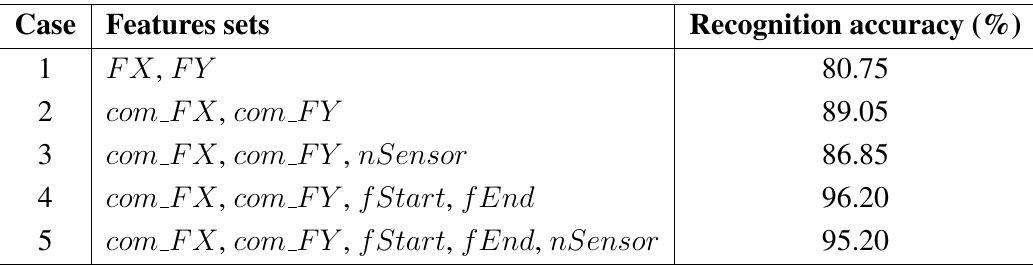
Table 5. Comparison of recognition accuracy of user identification by walking